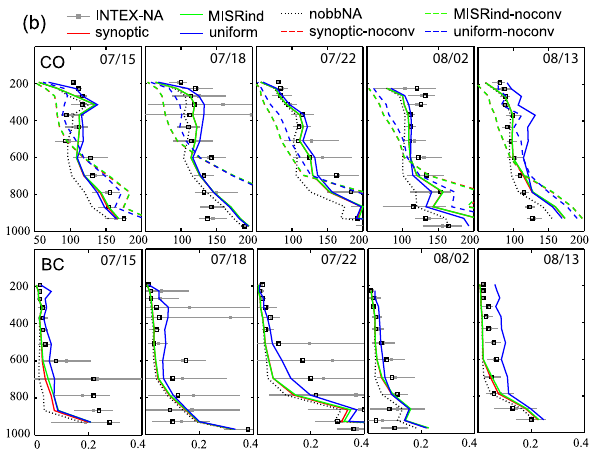
Fig. 9b. Same to Fig. 9a, but for representative individual